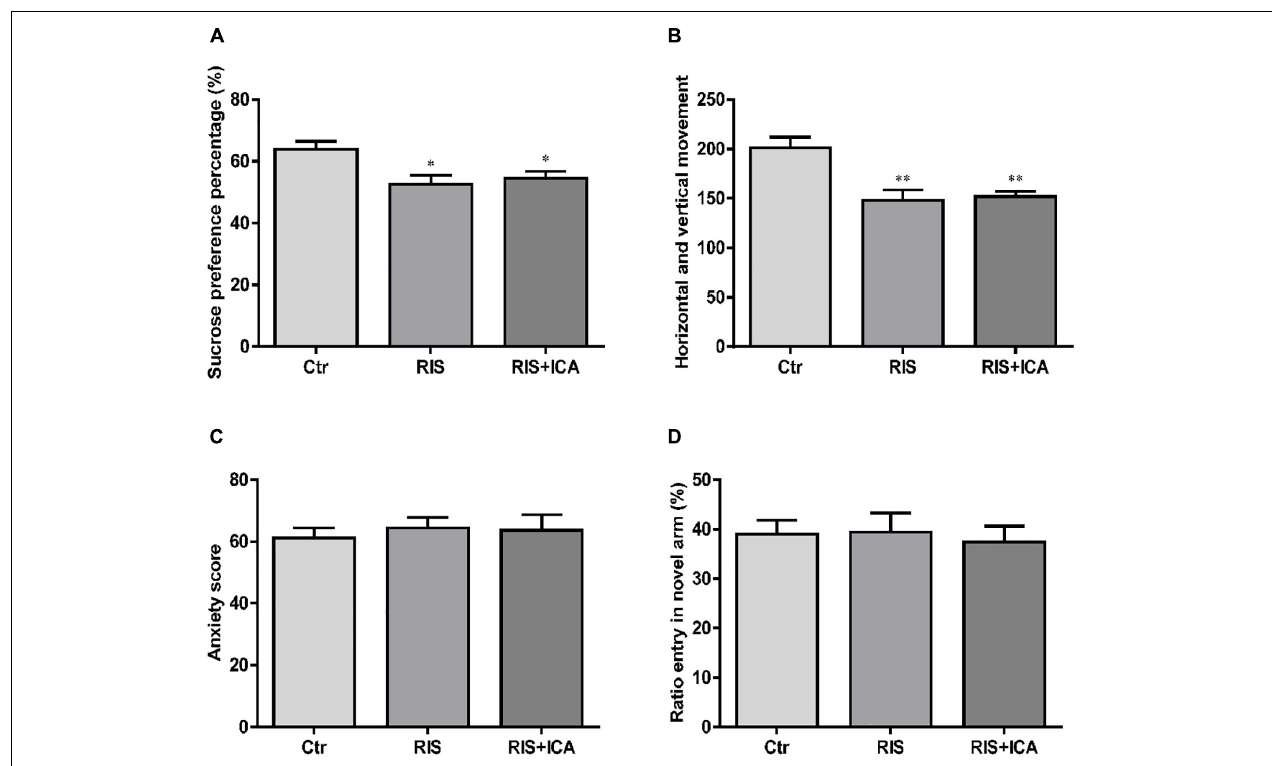
FIGURE 2 | Effect of RIS on behavioral changes in SPT (A) , OFT (B) , EPM (C) , and Y-maze test (D) . (A) Stress exposure significantly reduced the percentage of sucrose consumption in stressed APP/PS1 mice, in both the RIS and the RIS+ICA groups, compared with the control animals. (B) APP/PS1 mice in the two stress groups showed decreased horizontal and vertical movements compared with the control group. (C) Four weeks of RI stress exposure did not significantly change the anxiety score of mice in the two stress groups. (D) Four weeks of RI stress exposure did not significantly reduce the ratio entry. The results are expressed as the mean ± SEM, n = 10. ∗ p < 0.05, ∗∗ p < 0.01 vs. the control